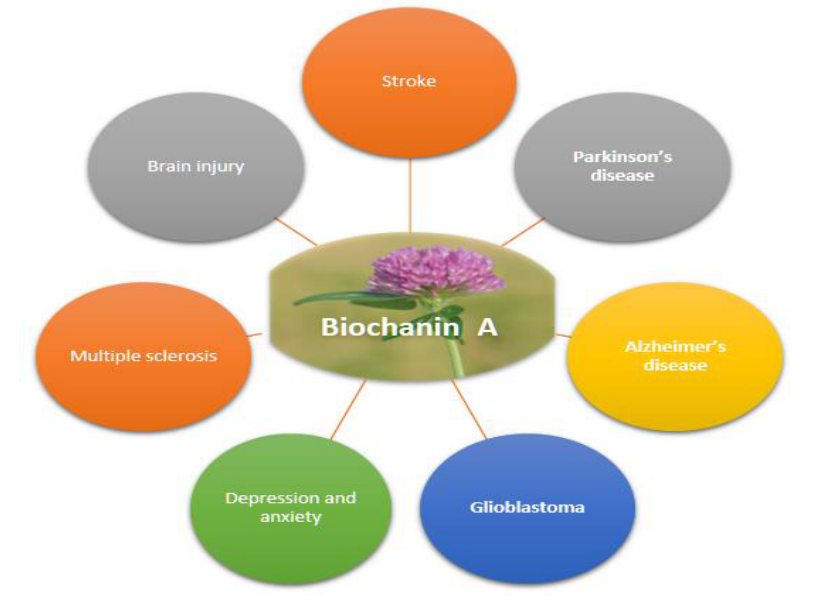
Fig. 2: BIO-A has a neuroprotective effect in multiple neurological